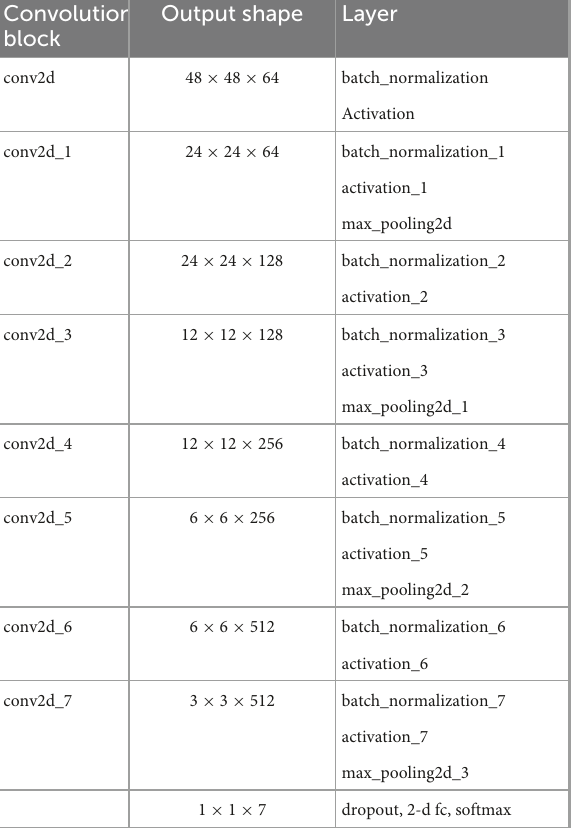
TABLE 1 The convolutional neural network for facial expression recognition. Convolution